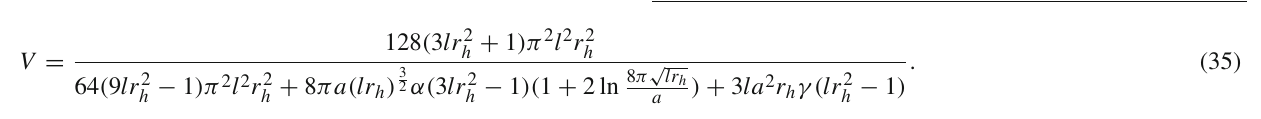
while the black hole volume by using the Eq.(17) obtained as follow,